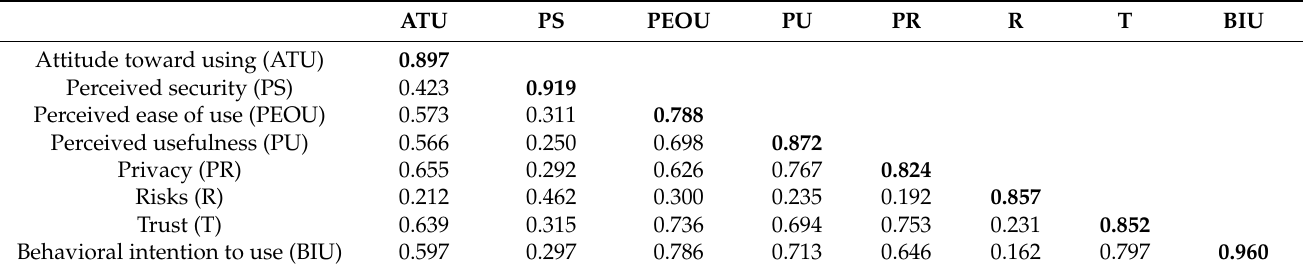
Table 3. Measurement model. Cronbach’s alpha, rho_A, composite reliability, and average variance extracted (AVE).